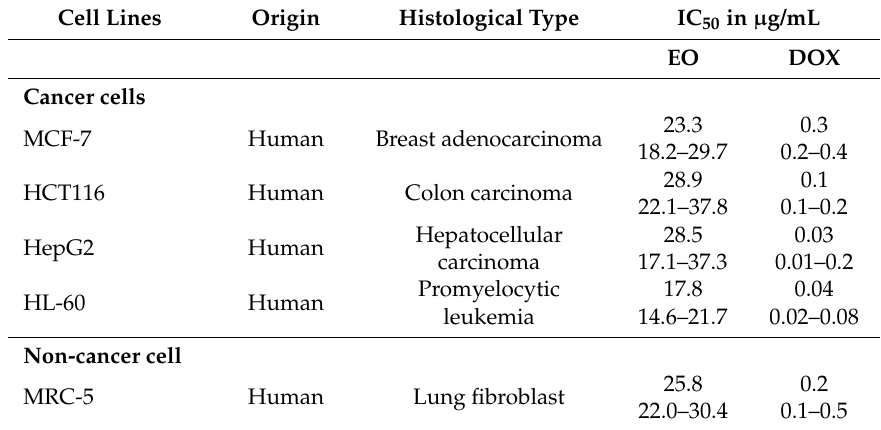
Table 2. Half maximal inhibitory concentration (IC 50 ) values of the cytotoxic activity of the essential oil (EO) from the leaves of Croton matourensis.